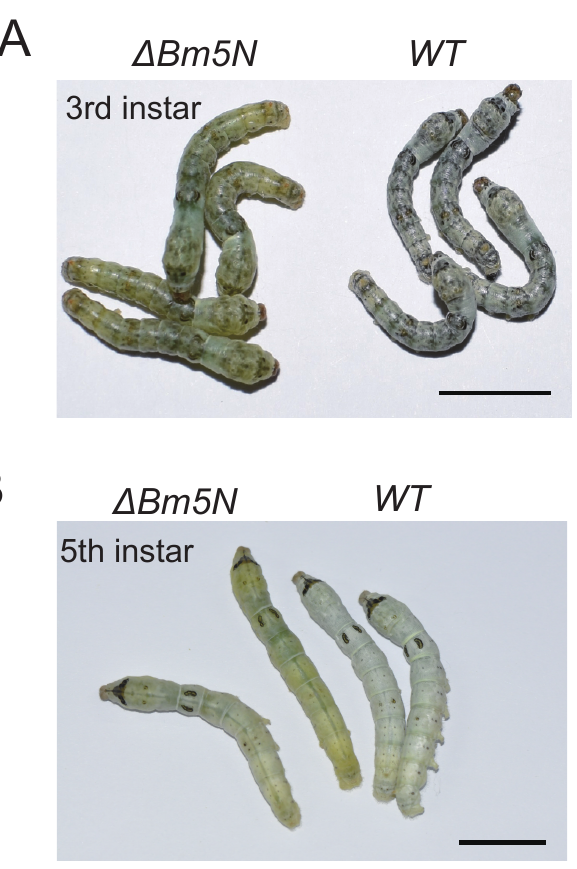
Figure 3. Bm5 (cid:48) N mutation results in the transparency of the larval integument. ( A ) Photographs of WT and ∆ Bm5 (cid:48) N G2 larva at the third instar. ( B ) Photographs of WT and mutant G2 larva at the fifth instar. Bars = 1 cm.